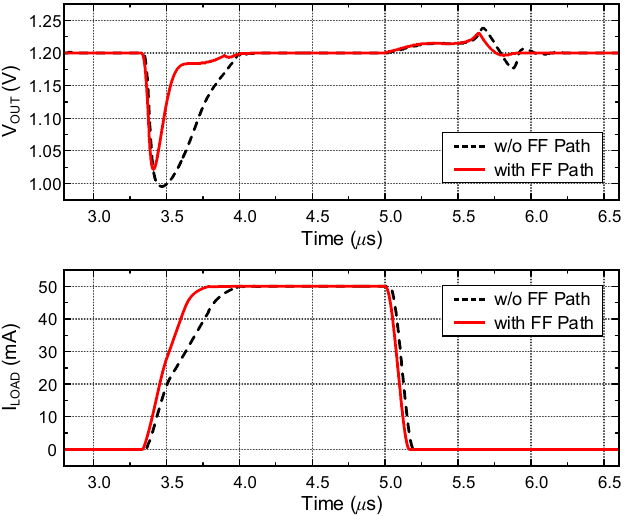
Figure 9. Simulated output voltage of load transient response with C L = 100 pF.